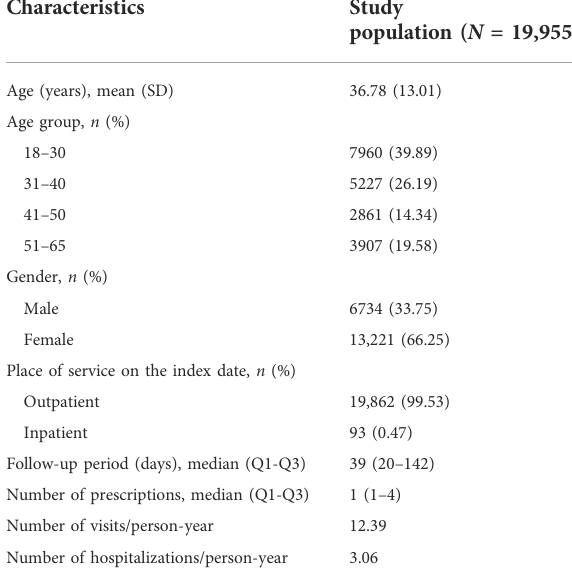
TABLE 1 Demographic and clinical characteristics of the study